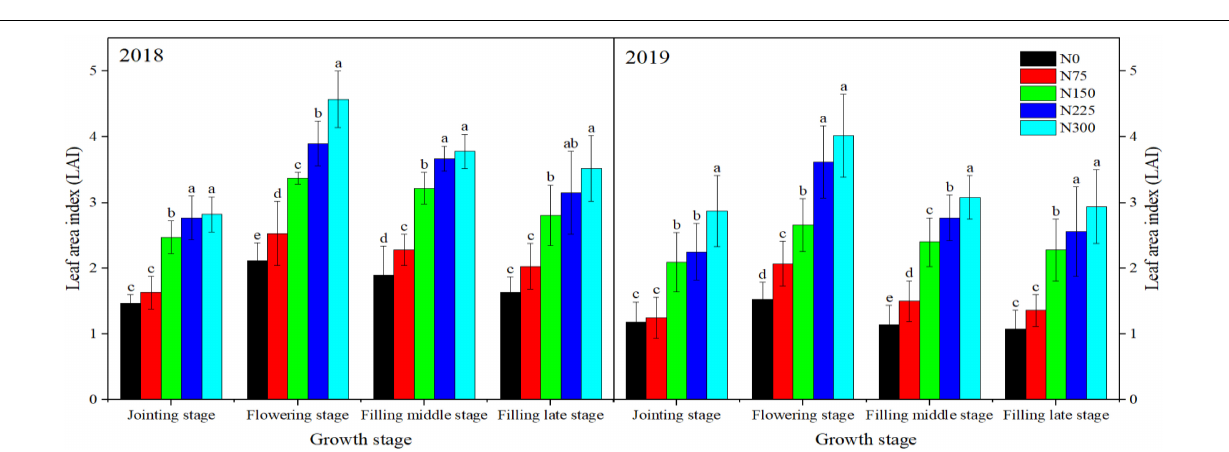
FIGURE 3 | Impact of different nitrogen (N) application rates on leaf area index at different growth stages in winter wheat during 2018 and 2019. Above bars, different small letters show significant differences among N treatments at each growth stage. N0: unfertilized control; N75: N application at 75 kg N · ha – 1 ; N150: N application at 150 kg N · ha – 1 ; N225: N application at 225 kg N · ha – 1 ; N300: traditional N application rate of 300 kg N · ha – 1